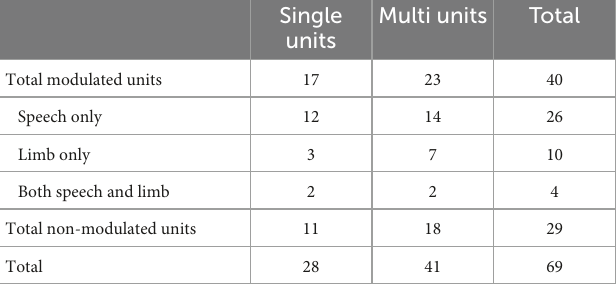
TABLE 2 Modulation of 69 identified neuronal clusters in response to tasks, based on RMI analyses.